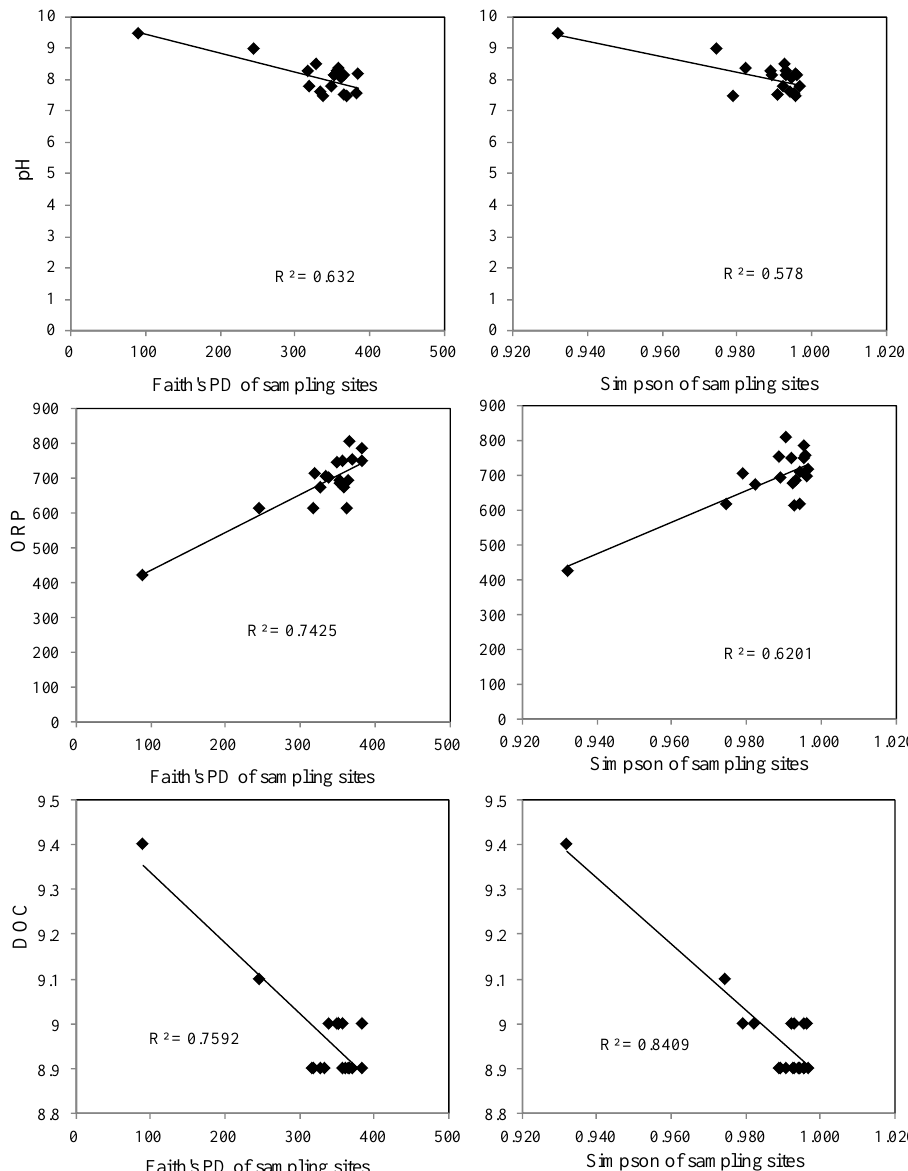
Figure4. ThesimplecorrelationbetweenthepH / ORP / DOCandFaith’sPD / Figure 4. The simple correlation between the pH/ORP/DOC and Faith’s PD/Simpson values, respectively.